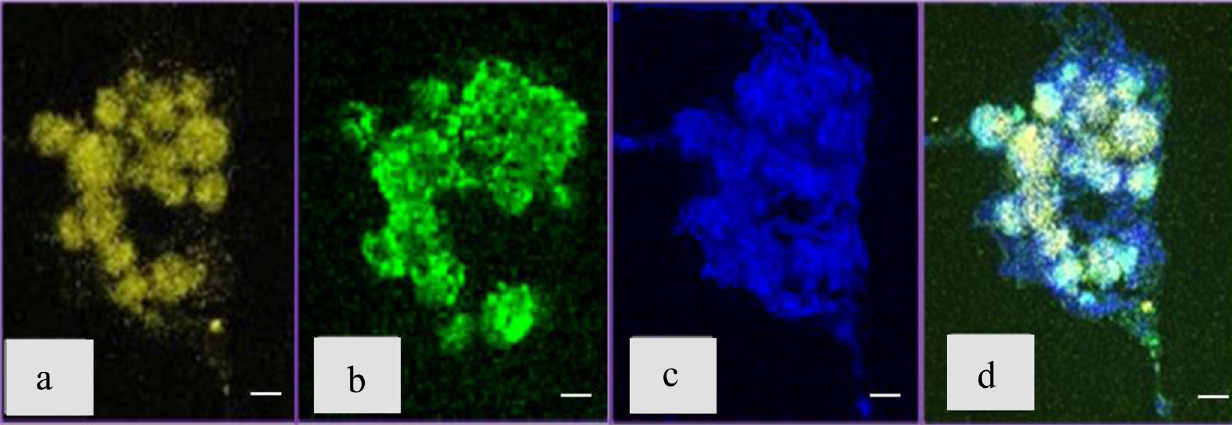
Fig. 5 B. cereus 4B at the fourth stage of the growth (45 h after inoculation). a Confocal microscopy image with CaCO 3 auto fl uorescence. b Confocal microscopy image with Sytox green (eDNA) staining. c Confocal microscopy image with Bromophenol blue staining (amyloid structures). d Confocal microscopy image with Sytox green (eDNA, green color), Bromophenol blue (amyloid structures, blue color) and CaCO 3 auto fl uorescence (yellow color); All scale bars correspond to 5